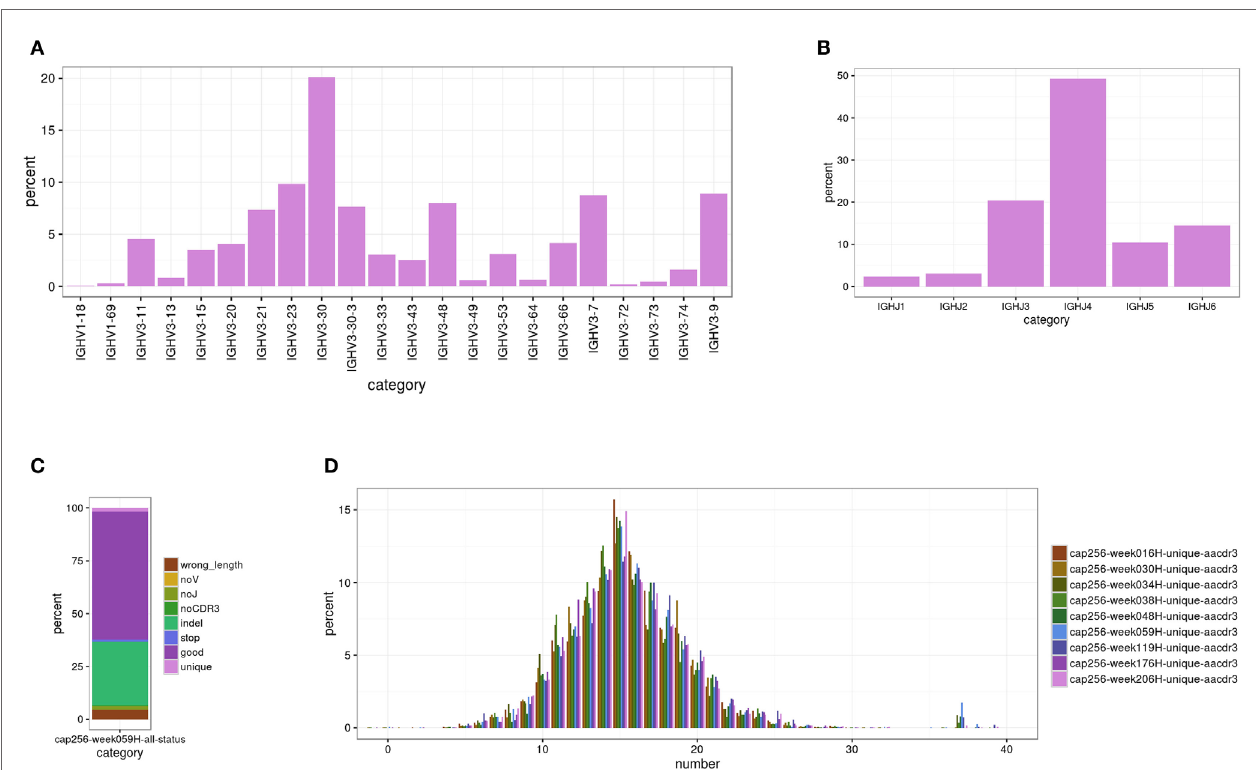
FIgURe 2 | sample figures for Module 1 analyses . (A) The V gene usage for donor CAP256 at 59 weeks post-infection (SRA ascension SRX395942). cDNA was amplified with VH3 family-specific primers; the peak for VH3-30 is from the expansion of the CAP256-VRC26 lineage. (B) The J gene usage for the same dataset. The CAP256-VRC26 lineage uses JH3. (C) The status assigned to each transcript in this dataset by SONAR. Approximately 30% of the transcripts are identified as containing in-dels (light green), which is typical for uncorrected 454 data. Approximately 60% are high-quality transcripts (dark purple), but only ~2% of these (~3% overall) are non-redundant at the 97% threshold (light purple). (d) CDR H3 length distribution (in amino acids, IMGT delineation) for all nine donor CAP256 time points. The CAP256-VRC26 lineage can be seen in the peak at 37 amino acids, which first appears at the 34 weeks post-infection time